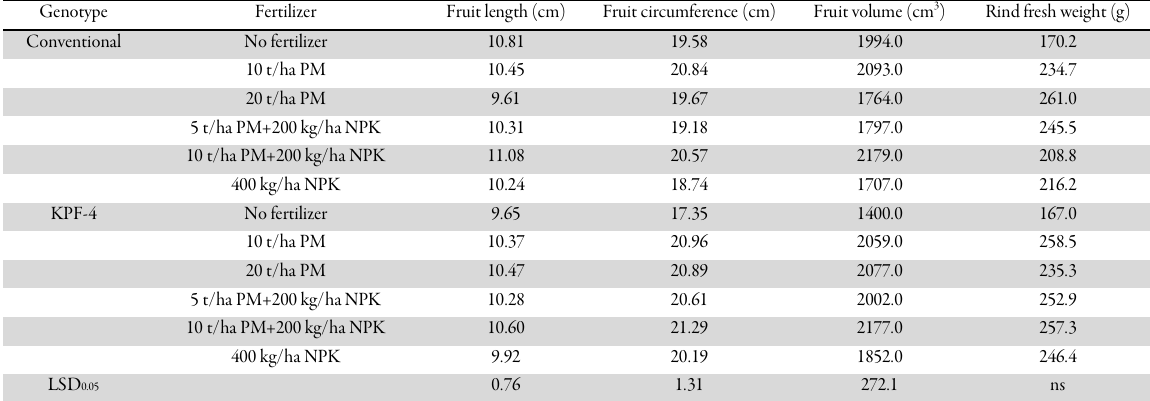
Table 5. Combined effect of genotype and fertilizer on fruit metric traits of two yellow passion fruit genotypes grown in the field in 2017 Genotype